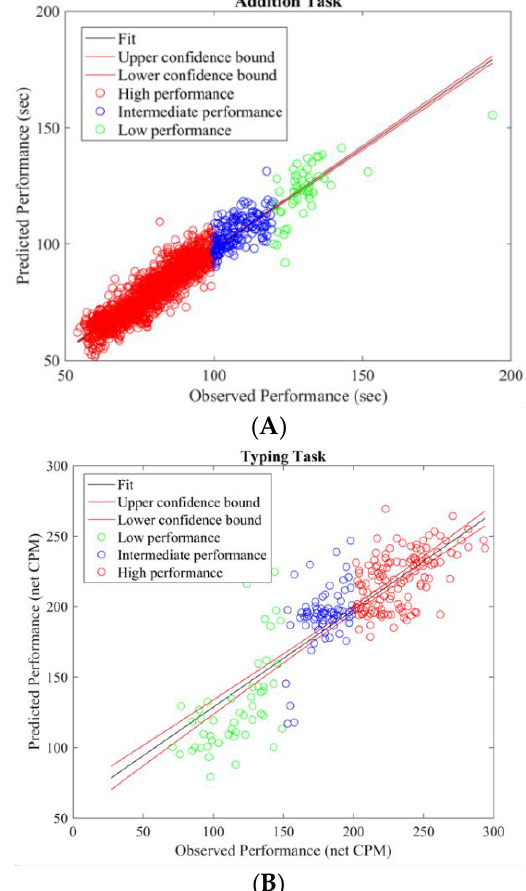
Figure 3. ( A ) Addition task—scatter plot of observed versus predicted performance (seconds) by using LASSO linear regression model with alpha power as a single regressor; ( B ) Typing task—scatter plot of observed versus predicted performance (net CPM) by using LASSO linear regression model with theta power as a single regressor.